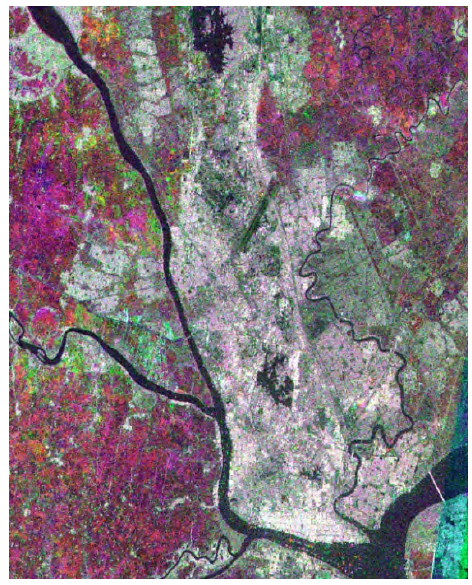
Figure 7. JERS 1 SAR Multi Temporal image of study area